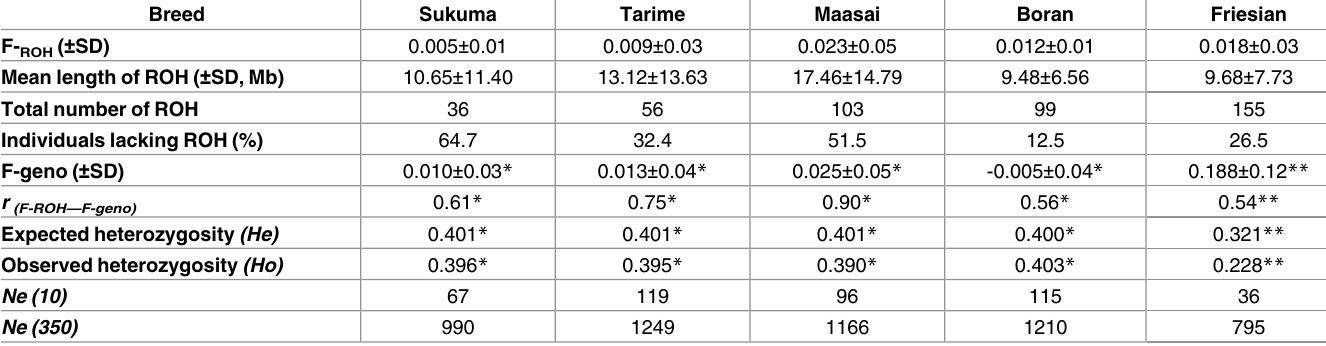
Table 1. Inbreeding coefficients and effectivepopulation size in Tanzanian cattle breeds. Breed